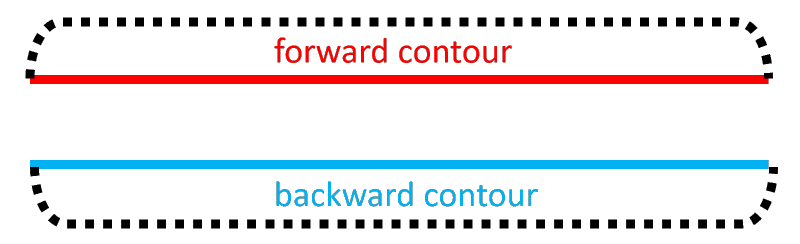
Figure 2 . Two disconnected periodic contours in opposite directions. Evaluating the path integral on this contour calculates an SFF. As shown, there is no interaction between the two contours and the SFF factors, but this factorization is destroyed by the introduction of a disorder